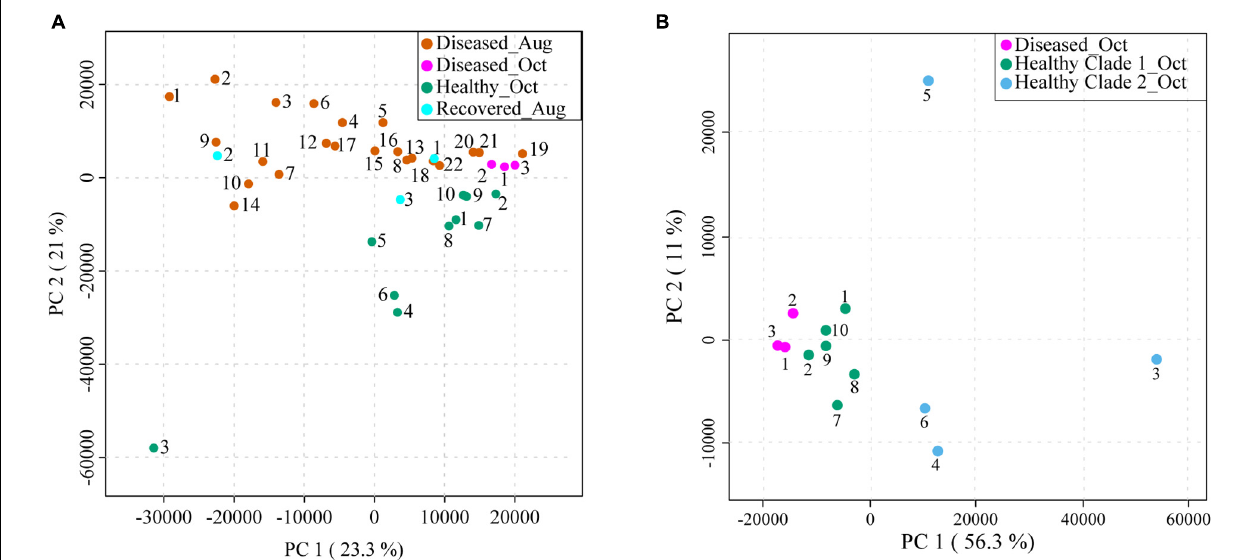
FIGURE 3 | Principal component analyses (PCA) of LC-MS-based metabolomics data acquired on syringe samples from M. cavernosa corals in Broward county, FL. (A) Shows PCA of all samples collected in August and October: Diseased_Aug (orange), Diseased_Oct (pink), Healthy_Oct (green), and Recovered_Aug (cyan). The healthy samples were collected only in October, whereas diseased samples were collected in both August and October. (B) Shows PCA of healthy (green and blue dots), and diseased (pink dots) samples collected in October. The healthy samples are displayed in two colors based on two clades observed for healthy samples in HCA analyses shown in Figure 4 and Supplementary Figure 3 . The amount of variance explained by each principal component is shown in parentheses on the corresponding axis. The clustering was supported by PERMANOVA analysis with F (p) value of 4.834